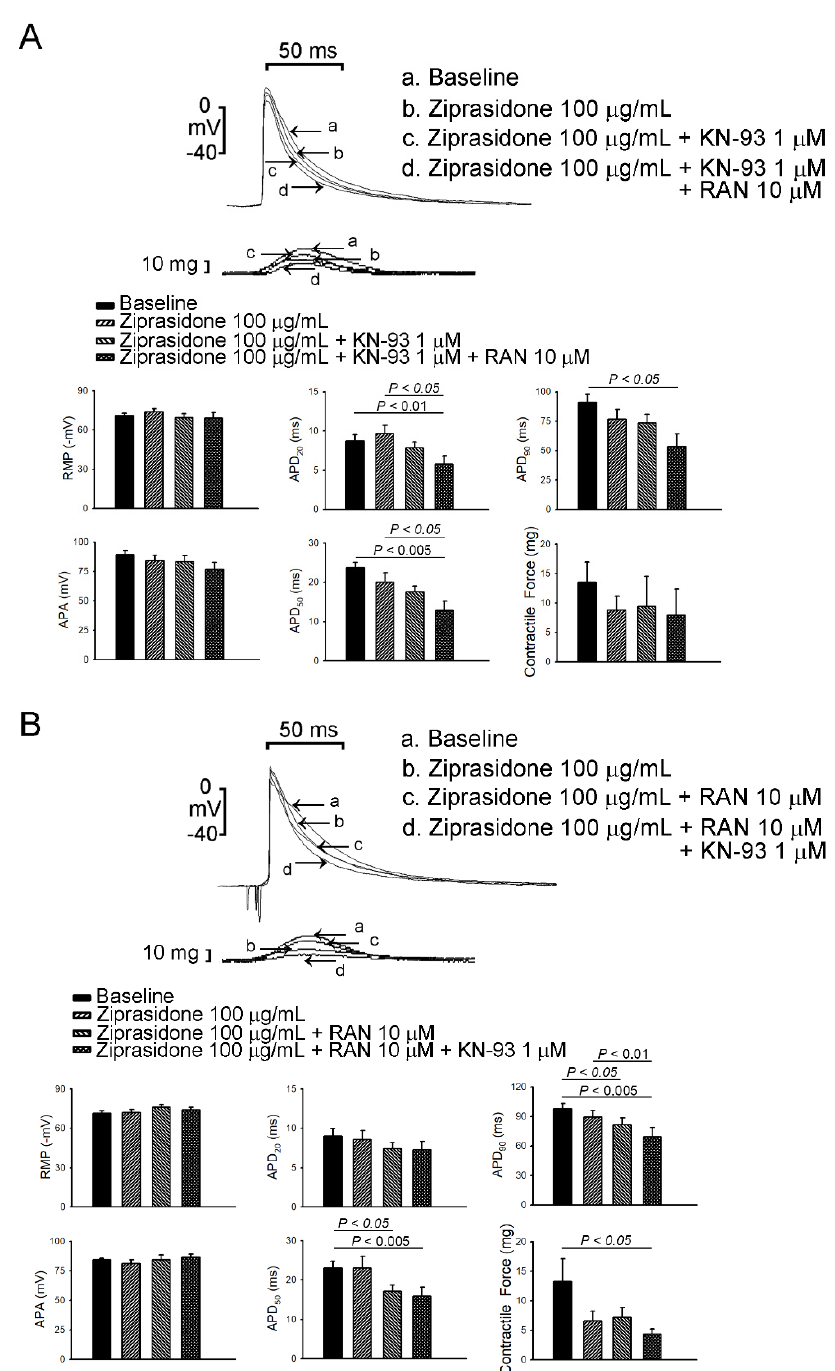
Figure 1. Effects of ziprasidone on action potentials of rabbit atriums. ( A ): (Upper) Representative action potentials and contractile forces from atrial tissues treated with ziprasidone, combined with KN-93 or KN-93 plus ranolazine, and (below) the mean data (N = 7) during electrical stimulation at a rate of 2 Hz. ( B ): (Upper) Representative action potentials and contractile forces from atrial tissues treated with ziprasidone, combined with ranolazine or ranolazine plus KN-93, and (below) the mean data (N = 7) during electrical stimulation at a rate of 2 Hz.